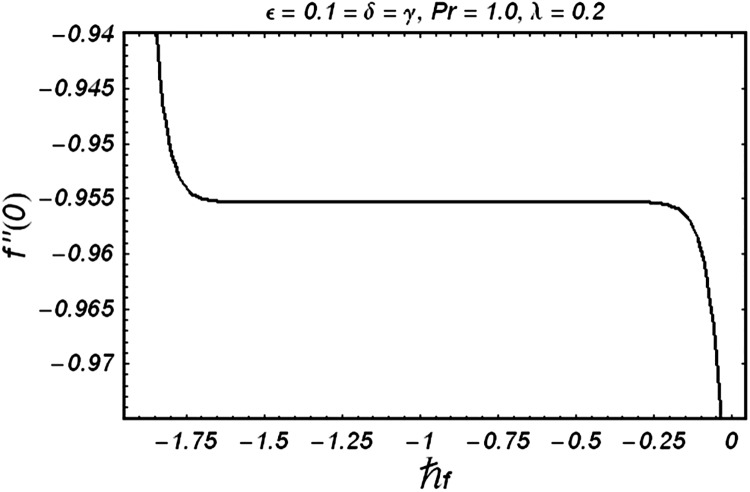
ℏf curve for velocity.